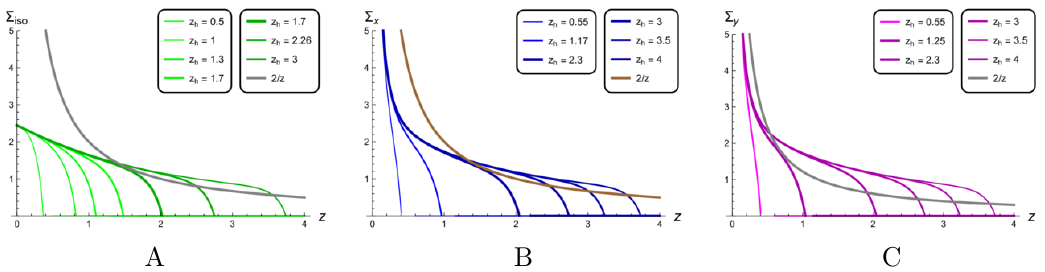
Figure 33 . A) Dynamical walls’ positions in isotropic case are given by the intersections of green lines representing (cid:6) iso ( z ) and the grey line representing 2 =z ; B) dynamical walls’ positions, cor- responding to the Wilson loop W x in the anisotropic case (cid:23) = 4 : 5, are given by intersections of blue lines representing (cid:6)( z ) and the brown line representing 2 =z ; C) dynamical walls’